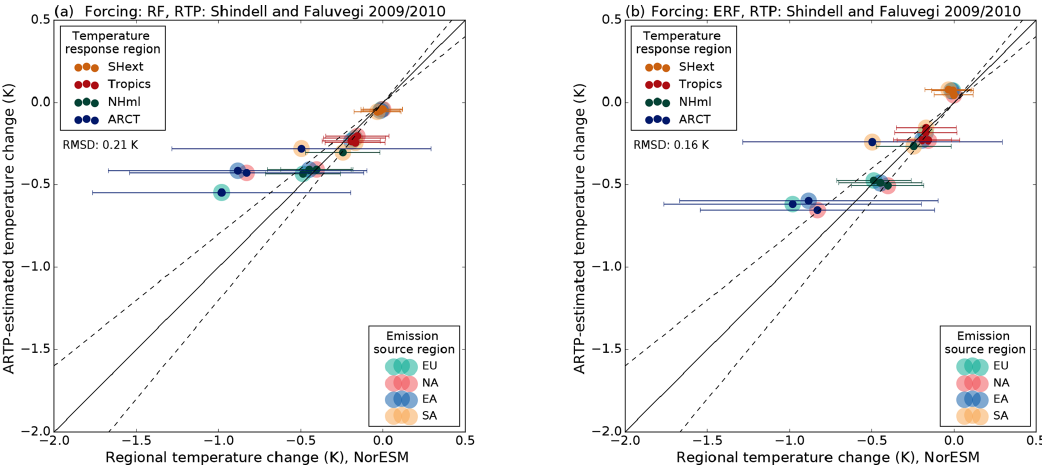
Figure 14. As Fig. 11 but with the RTP coefficients of Shindell and Faluvegi (2009), and with no climate sensitivity